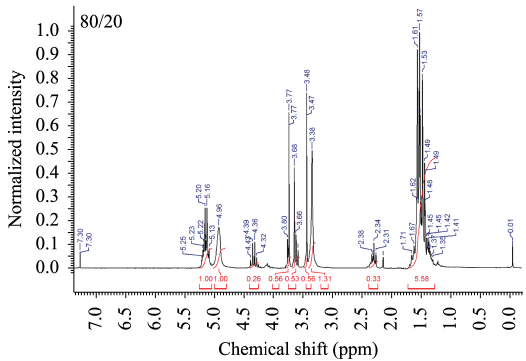
Figure 6. 1 H-NMR spectrum of a PLLA 80/20 sample obtained by solution polymerization after 24 hours of reaction at 120 °C. Table 4. PLLA and copolymers molecular weight (M polydispersity (M /M ) obtained by w n